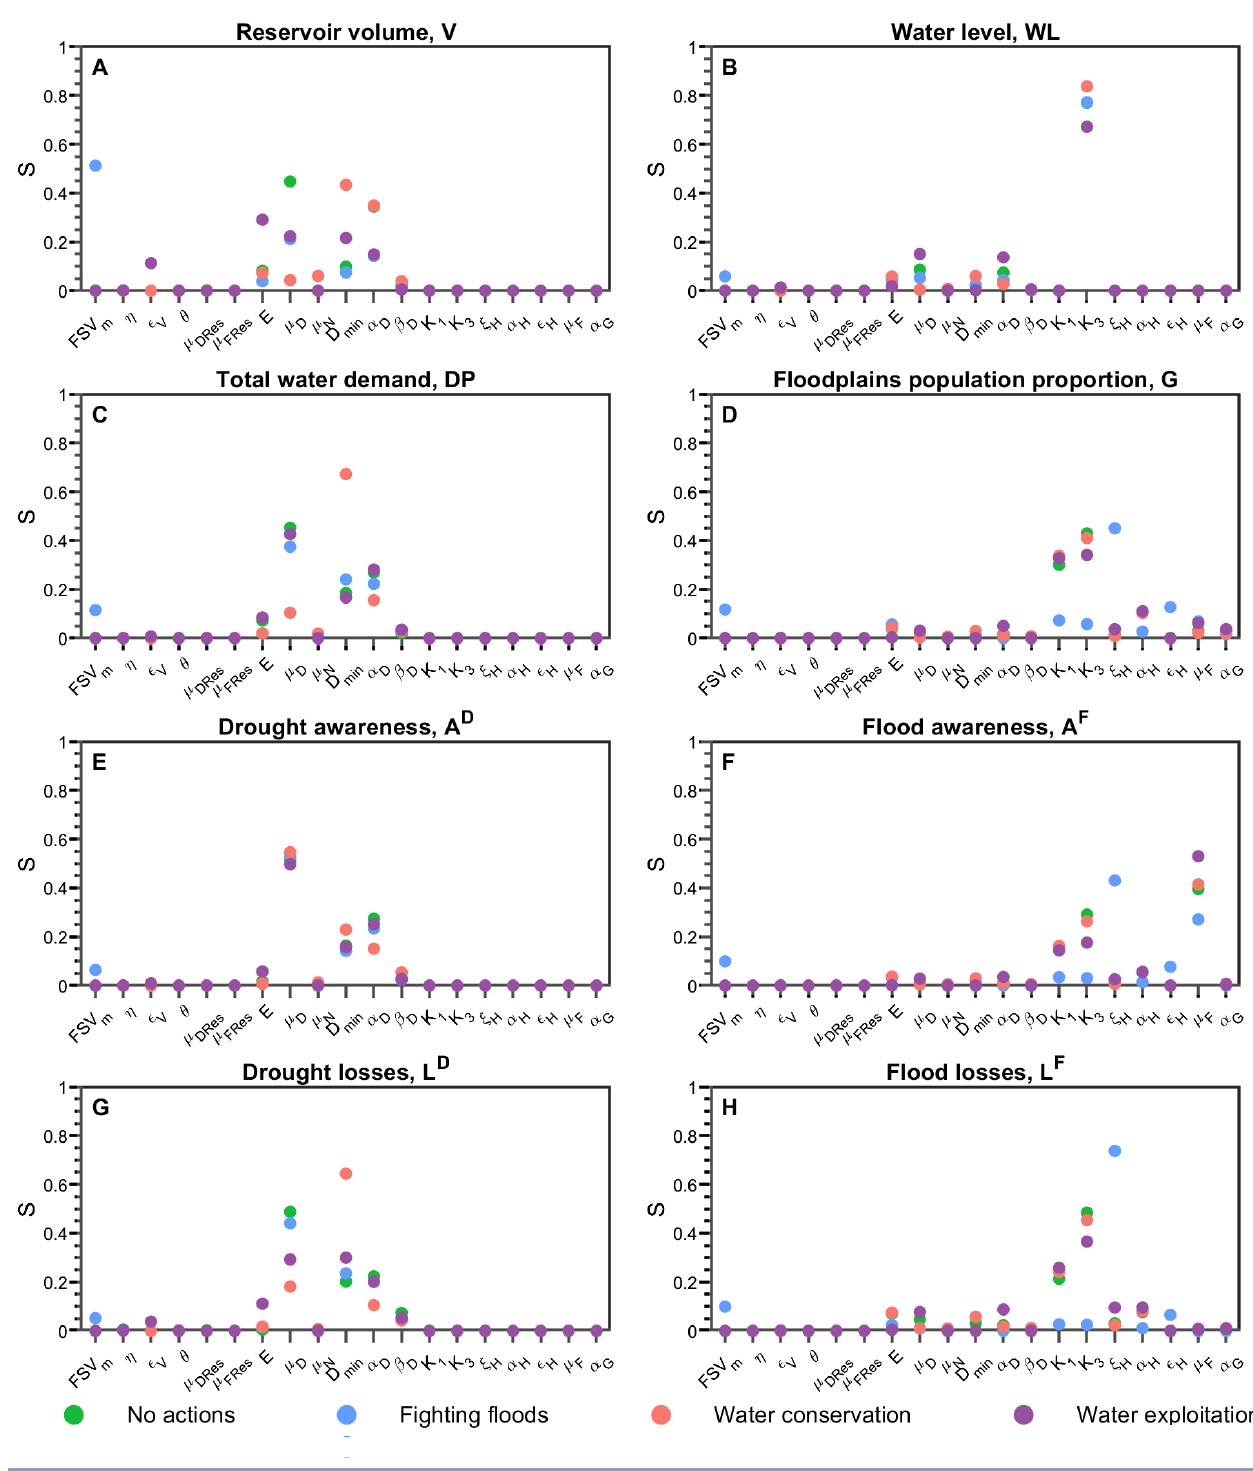
Fig. 9 . Sensitivity index of the selected model parameters showing the sensitivity of the (A) reservoir volume (V), (B) water level (WL), (C) total water demand (DP), (D) population living in floodplain areas (G), (E) drought awareness (A D ), (F) flood awareness (A F ), (G) drought losses (L D ), and (H) flood losses (L F ) with respect to the implemented water-management